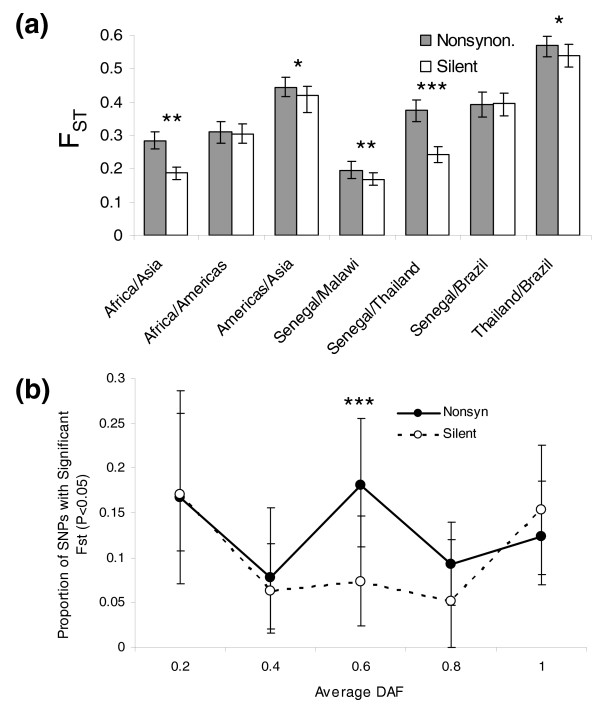
Nonsynonymous and silent divergence (FST). (a) Significantly greater nonsynonymous divergence (determined by bootstrapping) is indicated by asterisks: *P < 0.05; **P < 0.001; ***P < 0.0001. Error bars indicate 95% confidence intervals determined from bootstrapping. (b) Proportion of SNPs with significant Senegal versus Thailand FST (P < 0.05) controlling for average derived allele frequency in Senegal and Thailand.